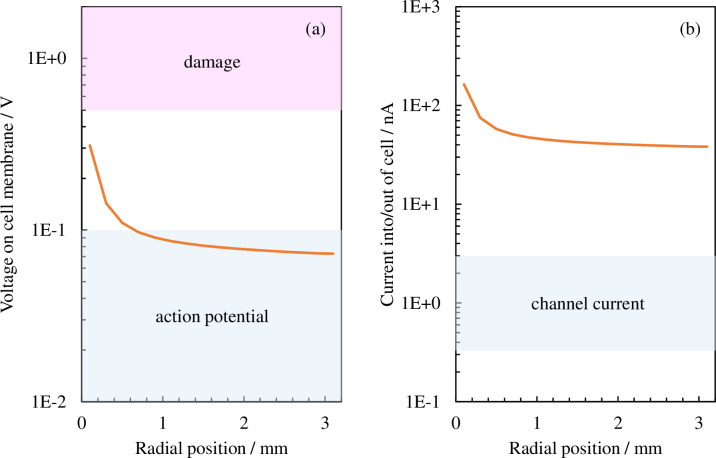
Distribution of effective values in the radial direction for (a) the voltage applied to the cellular membrane and (b) the electrical current flowing to the cell. The blue shaded regions in (a) and (b) indicate the action potential (approximately 0.1 V or lower) induced through normal cell activity and the electrical current value (of the order of 1 nA) caused by membrane transport through the ion channel, respectively. The red shaded region indicates the voltage (approximately 0.5 V or higher) wherein the cellular membrane would be damaged.